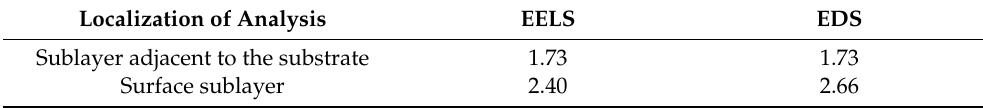
Table 6. Ti/N element content ratio, results reported in at.%.